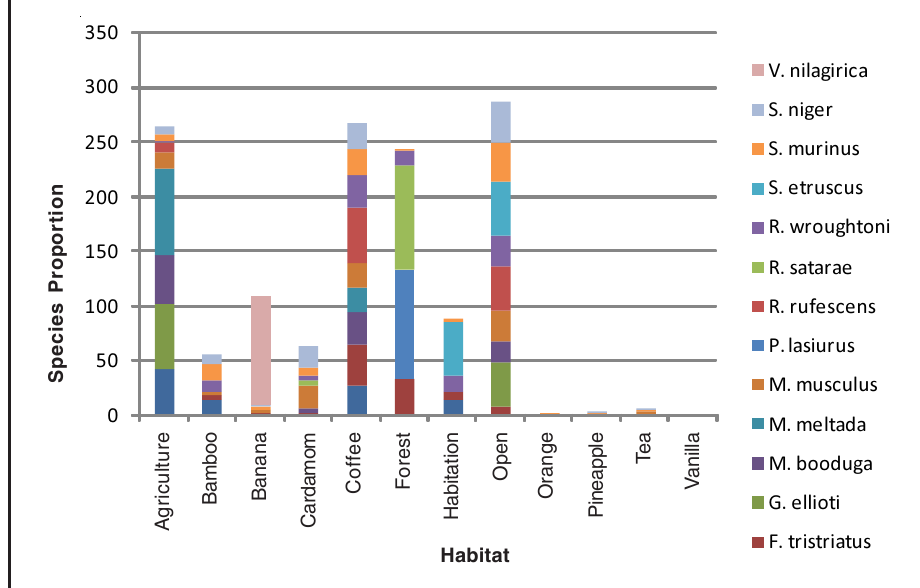
Figure 6. Habitats occupied by non-volant small mammals in proportions (stacked).